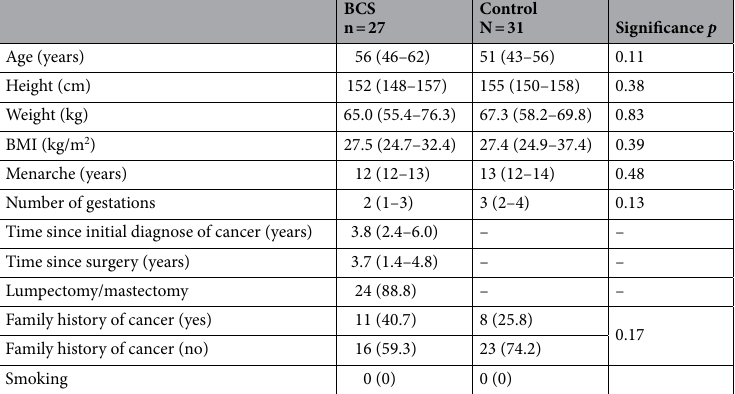
Table 1. General clinical characteristics of the study population. Data as presented as median (25th, 75th percentiles) or numbers (%). Mann–Whitney U test (continuous variables) between Breast cancer survivors (BCS) and Control groups. Fisher’s exact test for categorical